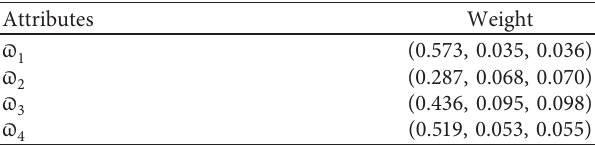
Table 17: The weights of attributes.